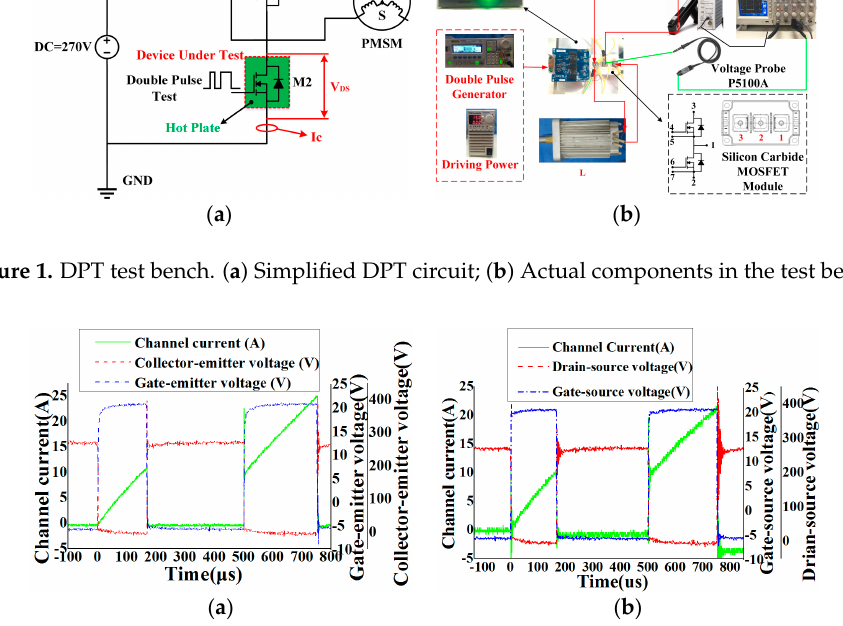
Figure 2. Total switching transitions. ( a ) Si IGBT; ( b ) SiC MOSFET.